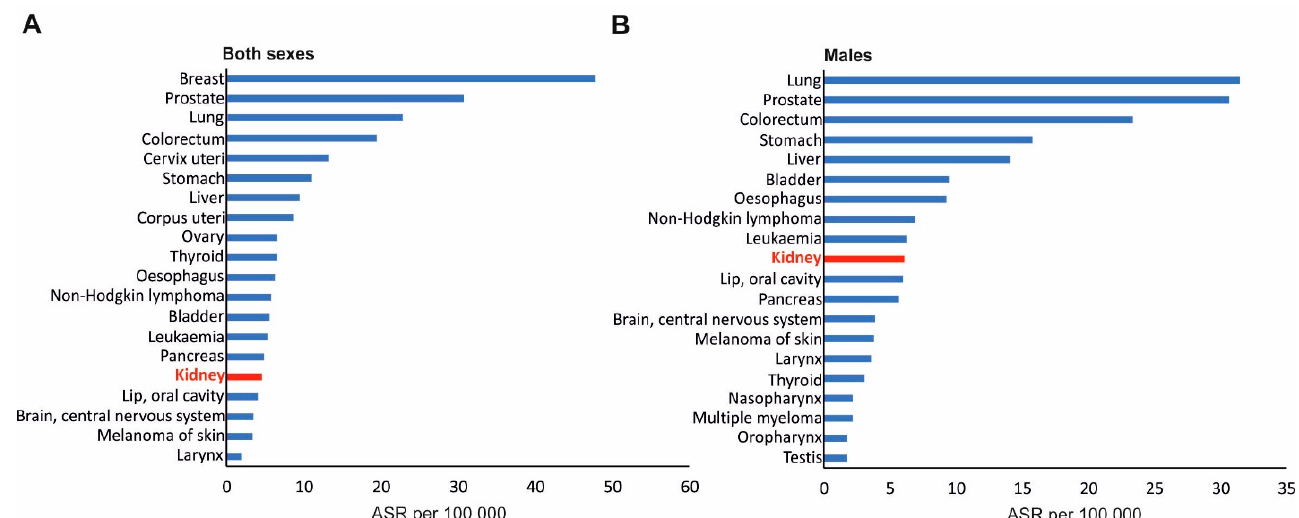
Figure 1. Twenty types of cancer with the highest incidence rates in 2020, worldwide, in both sexes ( A ) and in men ( B ). ASR (age-standardized rate) is a weighted mean of the age-specific rates where the weights are taken from the population distribution of a standard population; the ASR is expressed per 100,000. Kidney cancer is marked in red. Based on data from the Global Cancer Observatory of the International Agency Research of Cancer, IARC (https://gco.iarc.fr/, accessed on 1 May 2022).